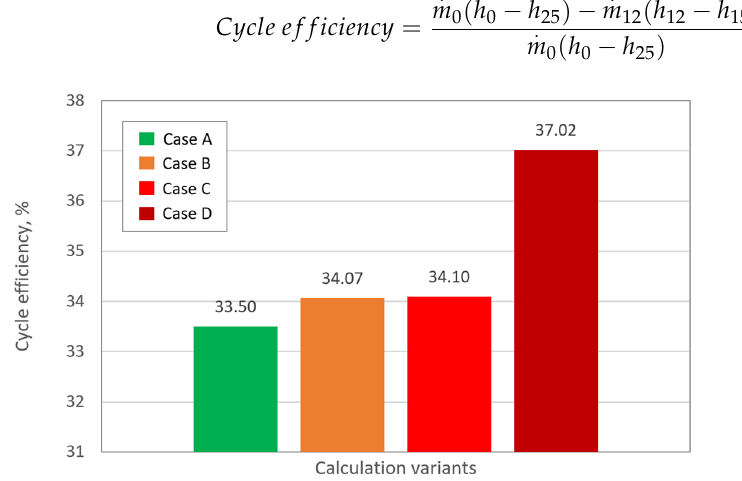
Figure 10. Cycle efficiency for different parameters of steam feeding the turbine.